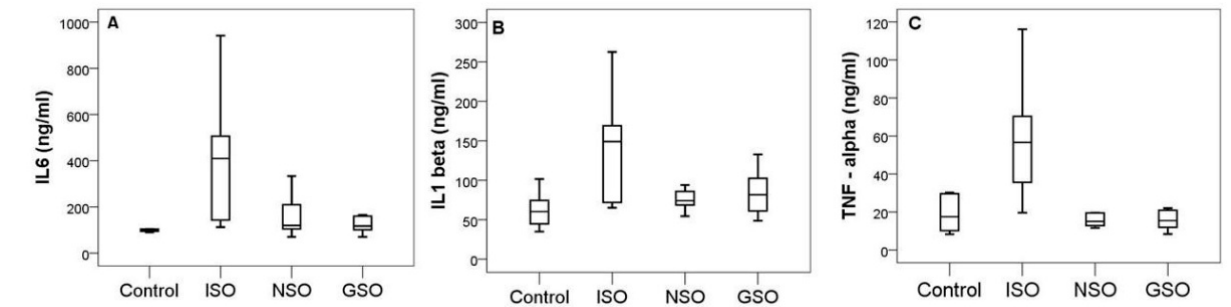
Figure 7. Serum levels of inflammatory markers IL6 ( A ), IL 1beta ( B ) and TNF-alpha ( C ) in the experimental groups.